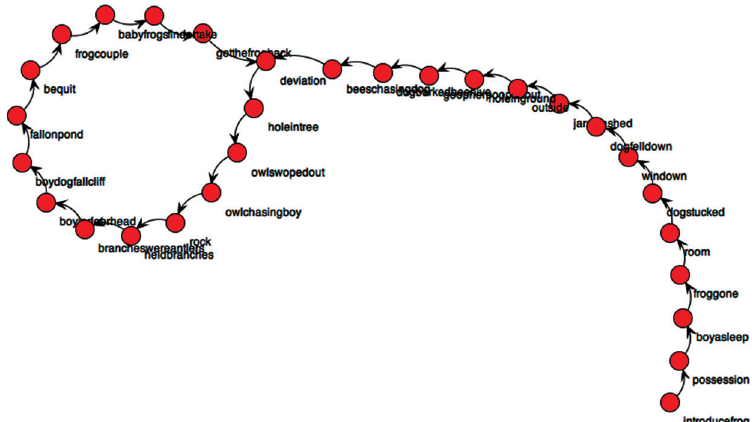
Figure 2. Control Subject (control 2).